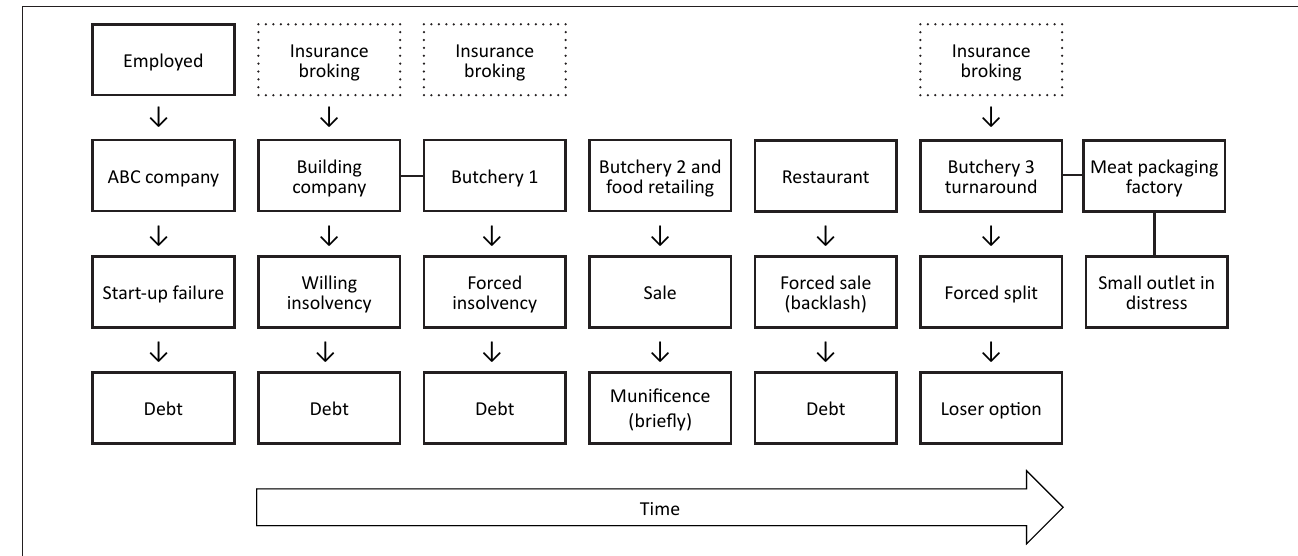
FIGURE 1: Sequence map of events and ventures pursued during the successive failures of one